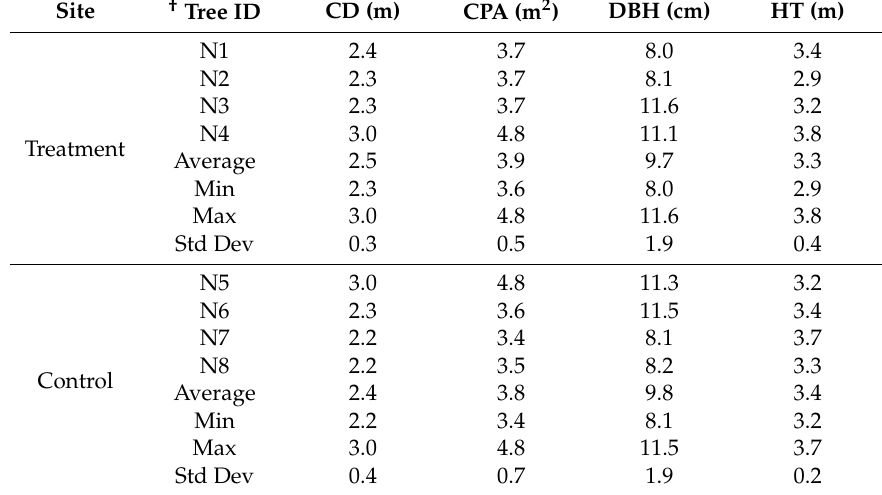
Table 4. Summary of Tree